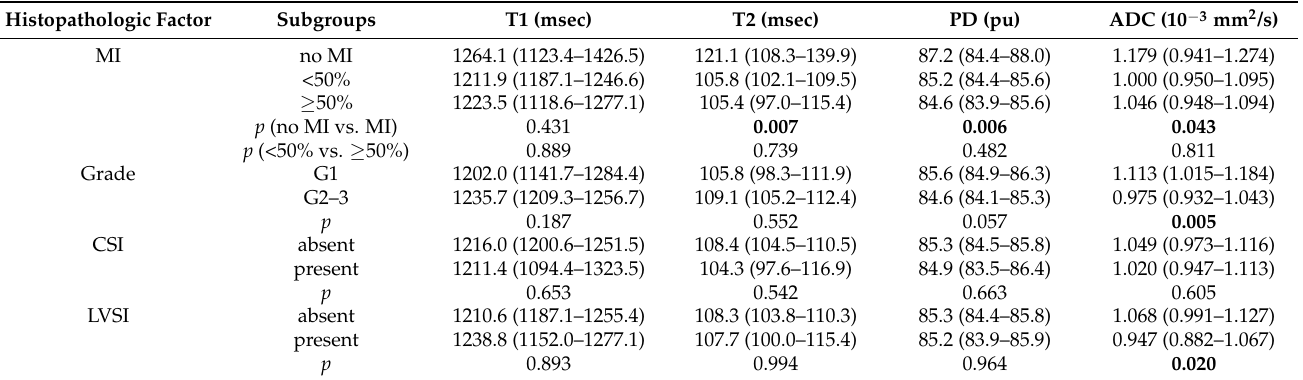
Table 3. Differences of T1, T2, PD and ADC values between the different histopathologic subgroups of endometrial carcinoma.